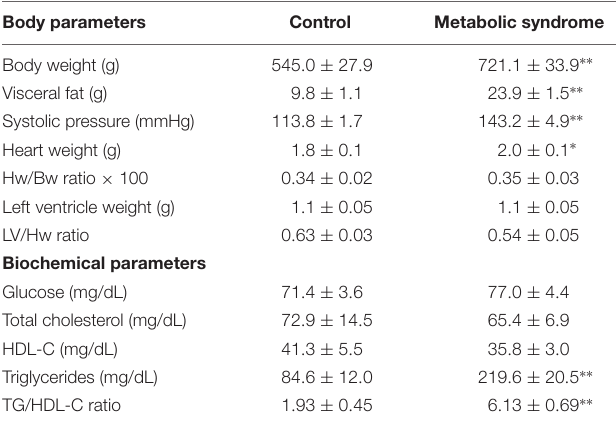
TABLE 1 | Body characteristics and biochemical parameters of metabolic syndrome and control